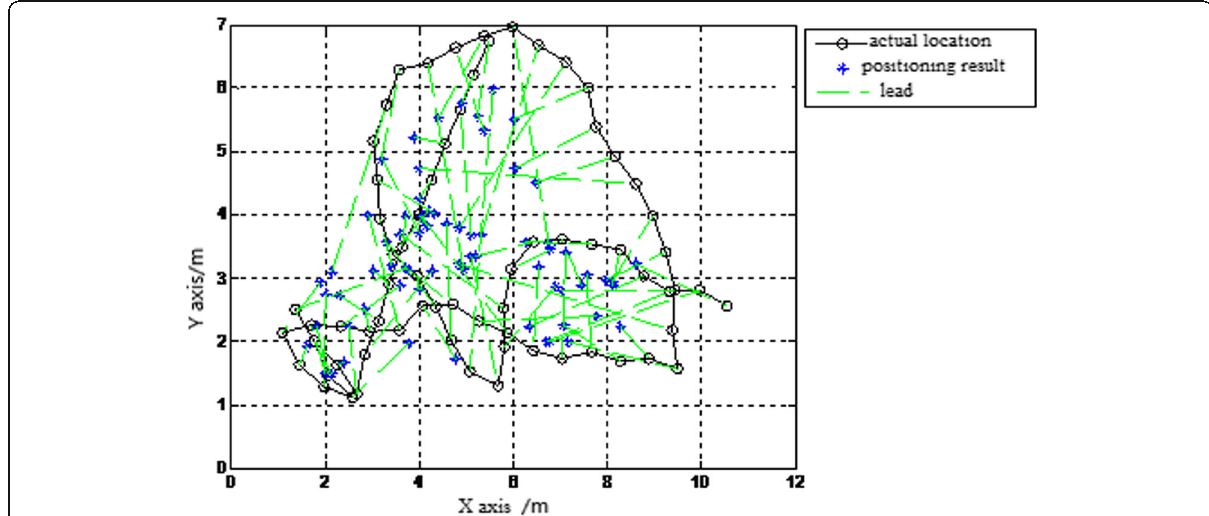
Fig. 9 Positioning result of joint balance metric improvement